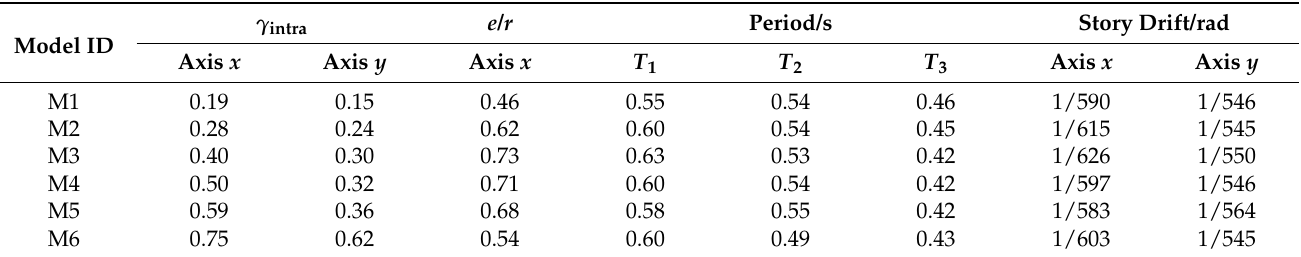
Table 4. Parameter of structure models.